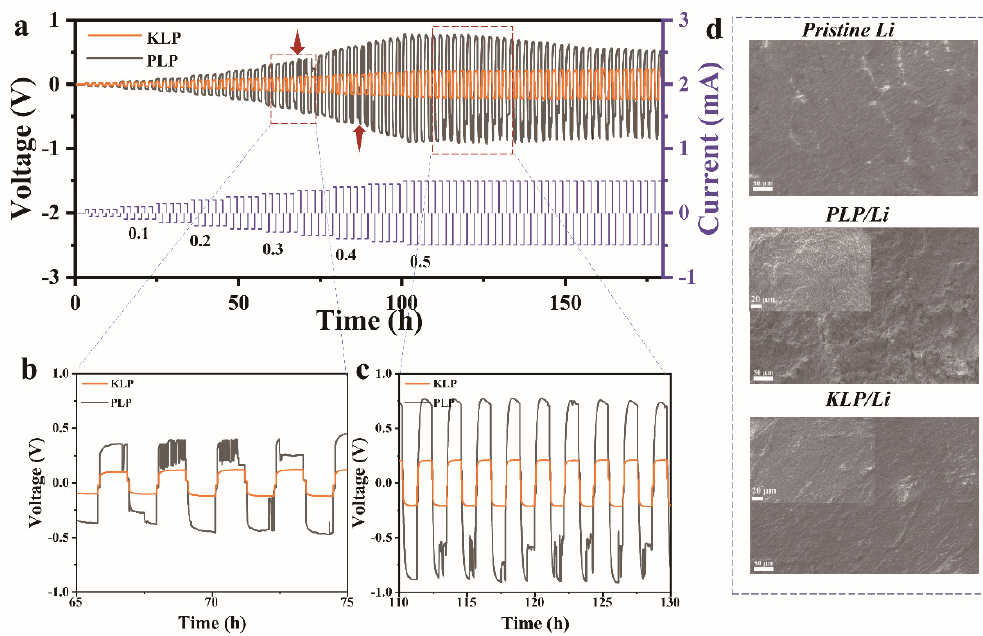
Figure 4. ( a ) Room temperature cycling performance of Li/KLP/Li and Li/PLP/Li lithium symmetric batteries at different current densities; ( b ) Enlarged plots at 0.3 mA/cm 2 current density; ( c ) Enlarged plots at 0.5 mA/cm 2 current density; ( d ) SEM topography of the initial lithium metal surface.